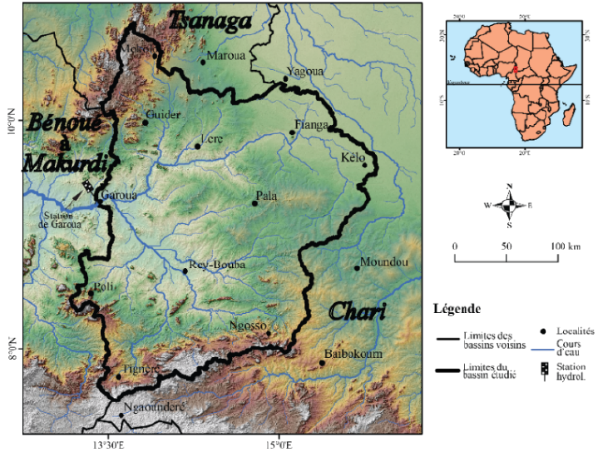
Figure 1. Localisation du bassin versant de la